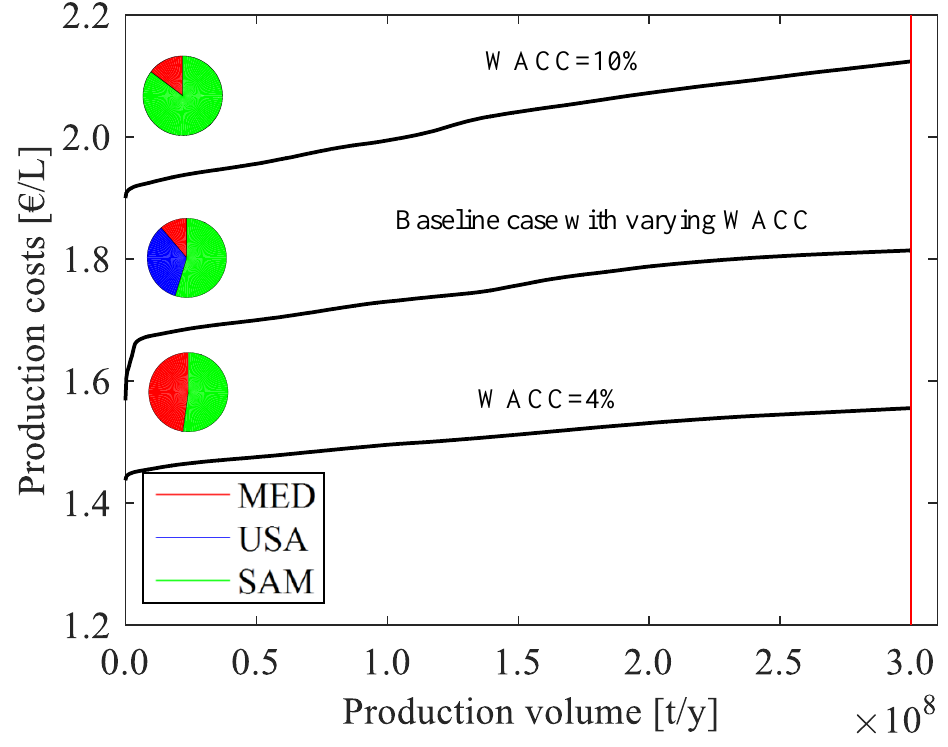
Figure 8. Cost-supply curves for the baseline case with varying nominal WACC between countries and constant nominal WACC in each country of 4% and 10%, respectively. The colors of the pie charts indicate the distribution of total production volumes over the regions for each case in the different regions of Europe, North Africa, and the Middle East (MED, red ), the USA (USA, blue ), and South America (SAM, green ). The graph only shows production volumes up to the current global jet fuel demand (indicated by the vertical red line).